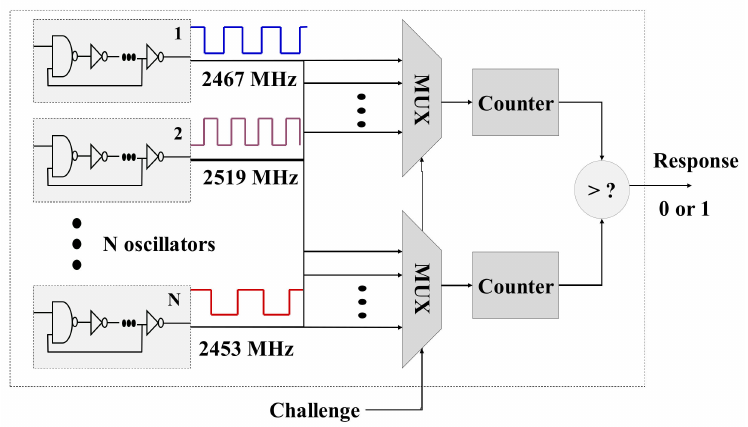
Figure 1. A typical ring oscillator physical unclonable function